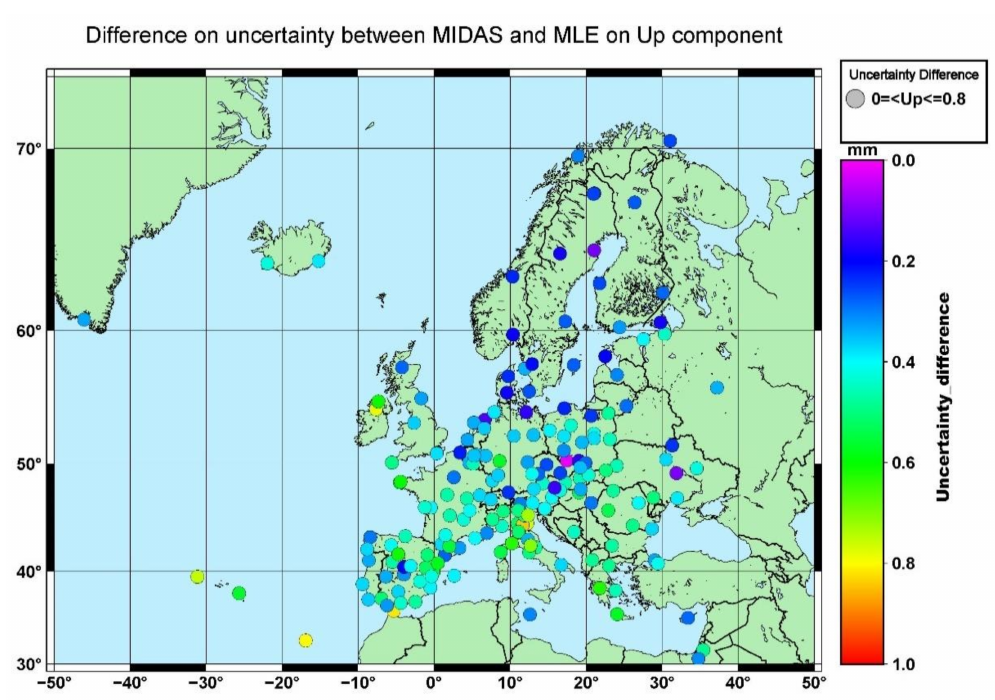
Figure 12. Stations’ velocity uncertainty difference between MIDAS and MLE for the Up component.